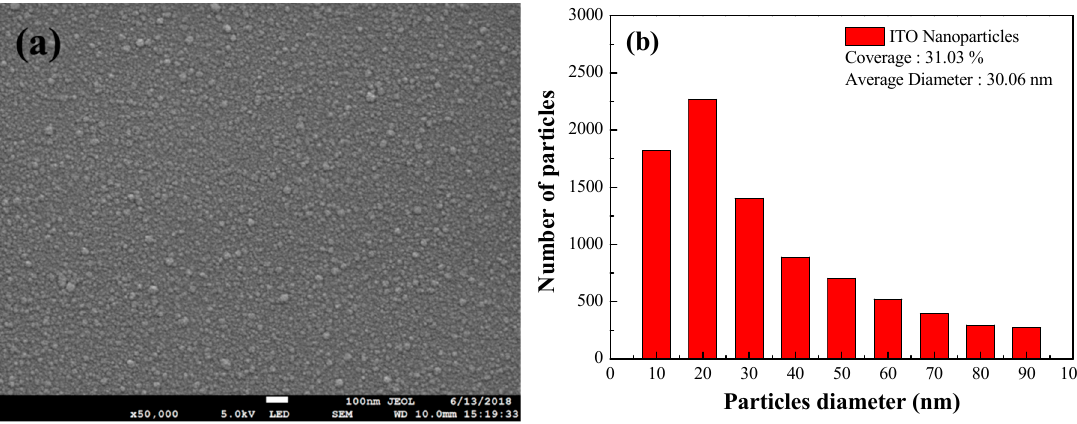
Figure 4. Top-view SEM images of ( a ) 3 wt% ITO NPs dispersed in the SiO 2 layer; ( b ) size distribution and coverage of 3 wt% ITO NPs, respectively calculated using Image-J software on the SEM image.